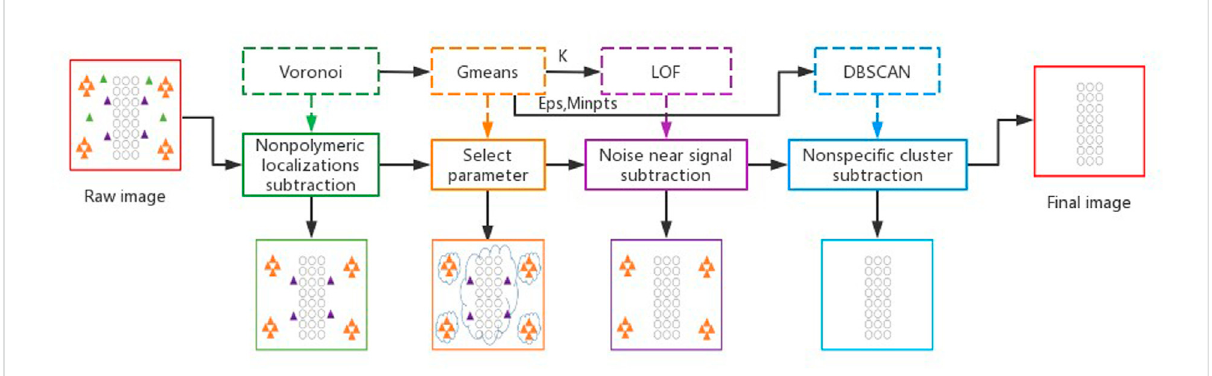
FIGURE 1 Themulti-stepadaptivenoisereductionframeworkforSMLMimage.Thecirclesrepresentsignalpoints,thetrianglesrepresentdifferenttypeof noise points. Orange triangles represent nonspeci fi c clusters, green triangles represent free non-polymer localization points, and purple triangles represent non-polymer localization points near the signal